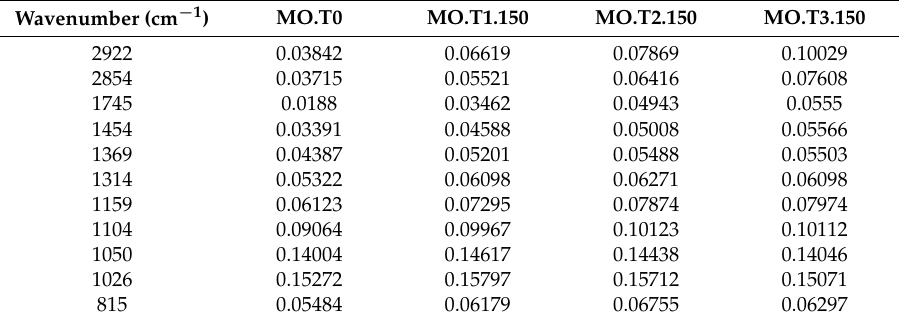
Table 4. Peak absorbance values of IR spectra of paper samples aged in mineral oil at 150 ◦ C.